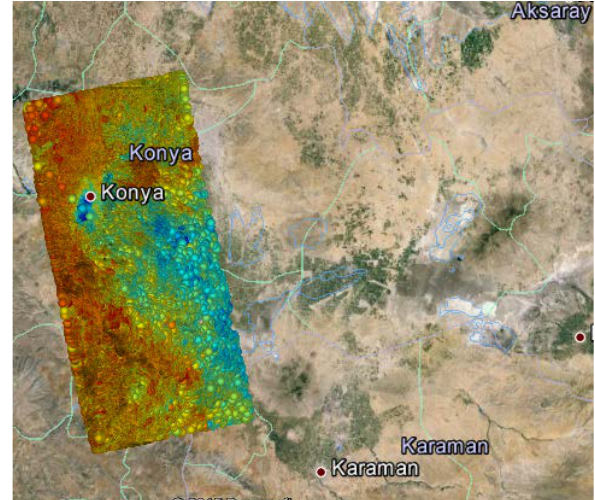
Figure 13. StaMPS PS InSAR of Envisat track 114, blue colour means subsidence of down to 25 mm/year, red colour would mean an uplift of less than 5